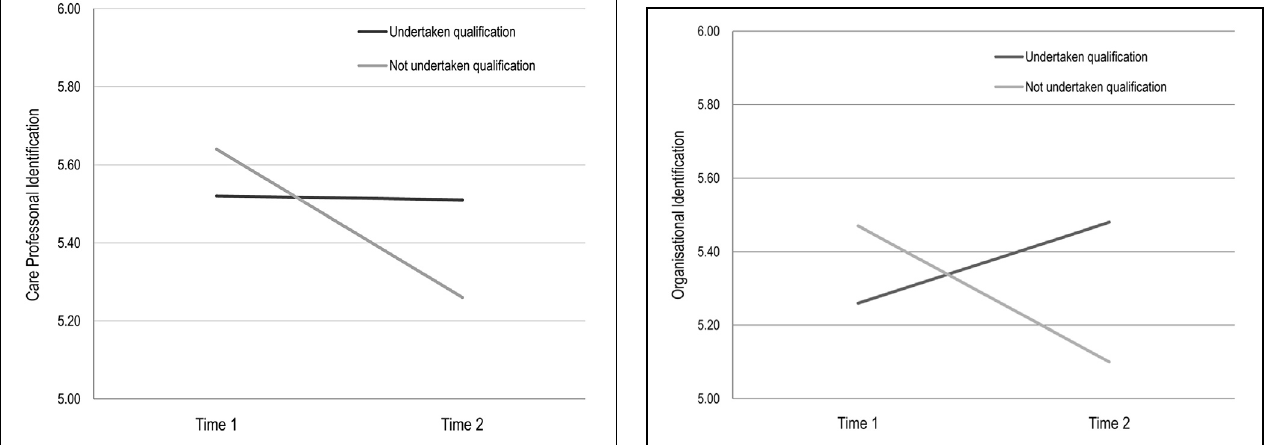
FIGURE 3 | The effects of undertaking a qualification on care professional identification, Longitudinal panel data.